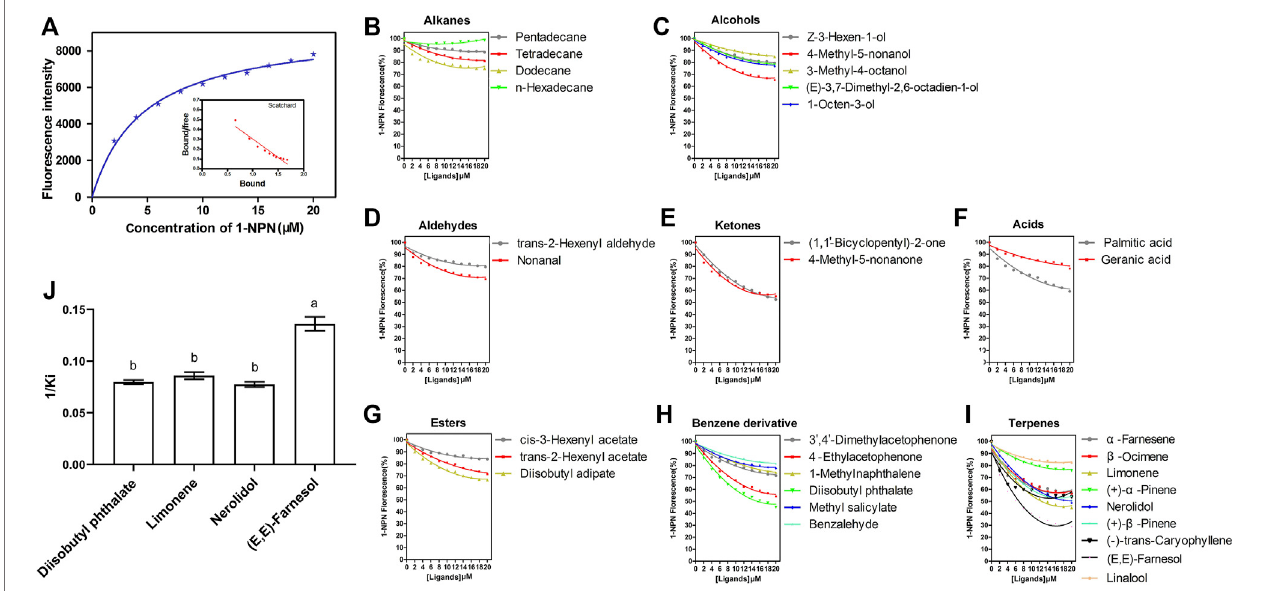
FIGURE8| FluorescencecompetitivebindingassayshowedthebindingpropertyofSvelOBP15of Sympiezomiasvelatus toall33testedchemicals. (A) represents the binding curve and Scatchard plot of the SvelOBP15 protein with 1-NPN; (B – I) represent competitive binding curves of SvelOBP15 to aliphatic hydrocarbons, alcohols, aldehydes, ketones, esters, acids, benzene derivatives and terpenes, respectively; (J) represents reverse values of dissociation constants (Ki) of SvelOBP15, and different lowercase letters indicate signi fi cant differences at the 0.05 level (one-way ANOVA followed by Tukey ’ s test).